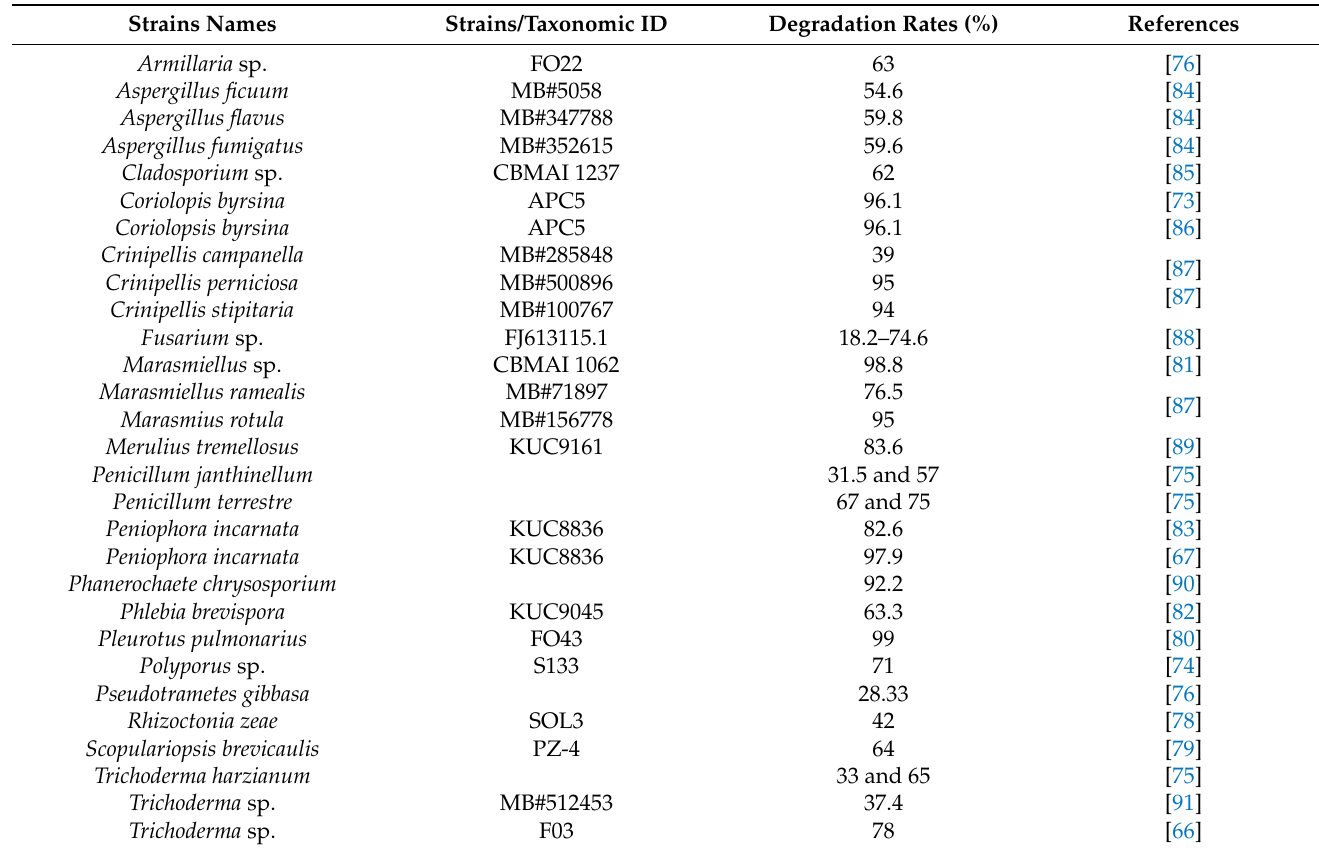
Table 2. Pyrene-degradation efficiency of some different fungal